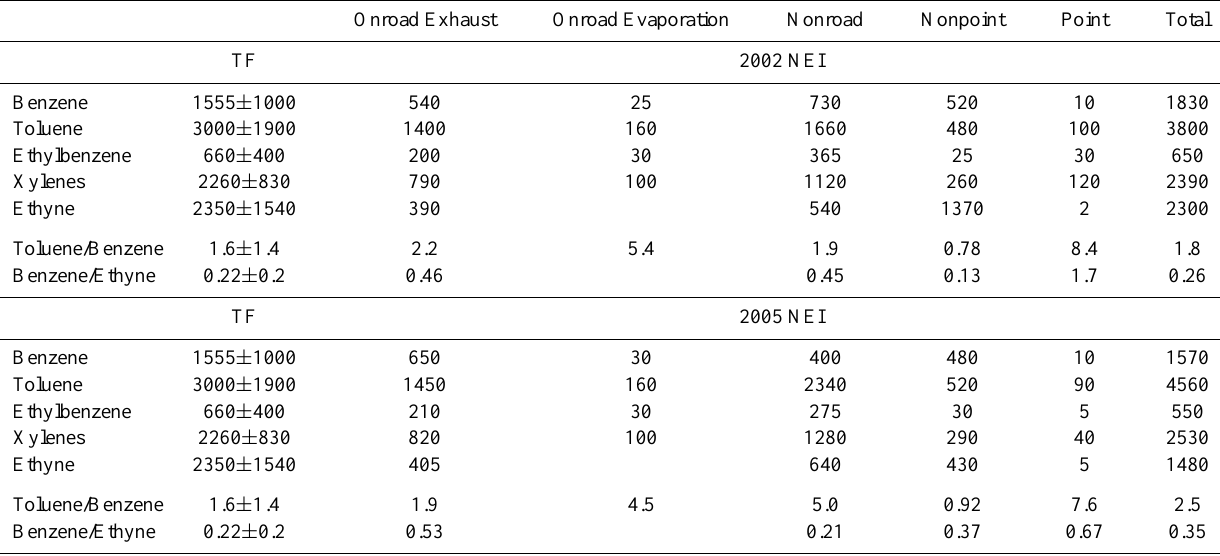
Table 4. Emission rates (Mg/year) of benzene, toluene, ethylbenzene, xylenes (m+p+o), and ethyne and the toluene/benzene and ben- zene/ethyne ratios from the 2002 and 2005 EPA National Emissions Inventory (NEI) for New Hampshire. The TF column is the emission rate (Mg/year) estimated using the winter 2006 TF GC nighttime measurements from Table 3. The toluene/benzene and benzene/ethyne ra- tios were calculated by converting the emission rates for TF and for the respective source category listed in this table to molar concentrations. The TF toluene/benzene and benzene/ethyne ratio errors were propagated from the error in the TF emission rates. Onroad Exhaust Onroad Evaporation Nonroad